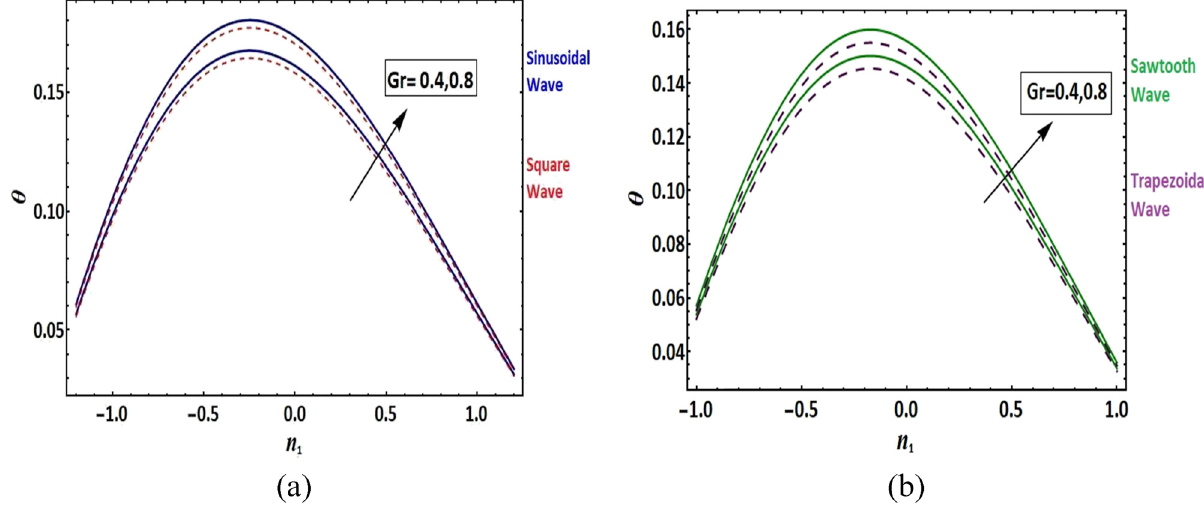
Figure 11: ( aandb ) Temperaturepro fi lefor λ 1 = 0.5, M = 0.2,Sc = 0.5, ϕ